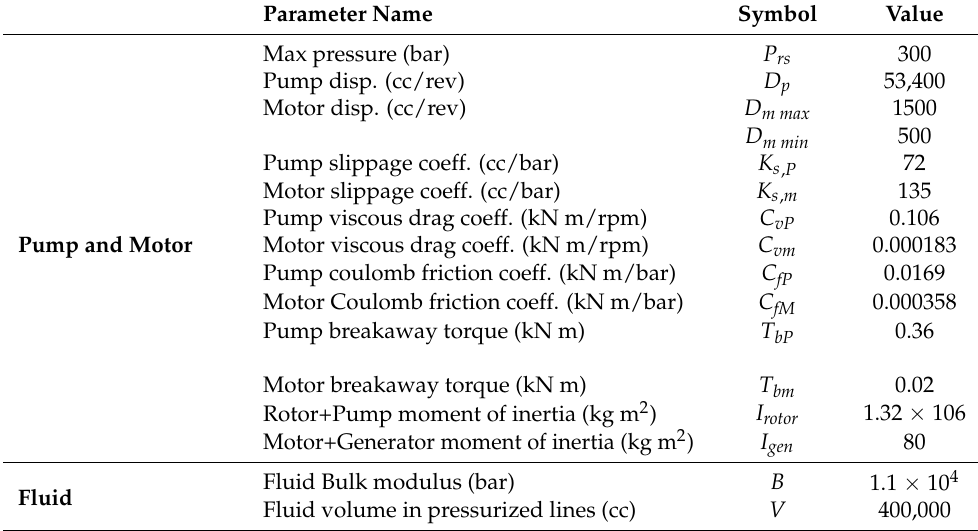
Table 1. HTS component